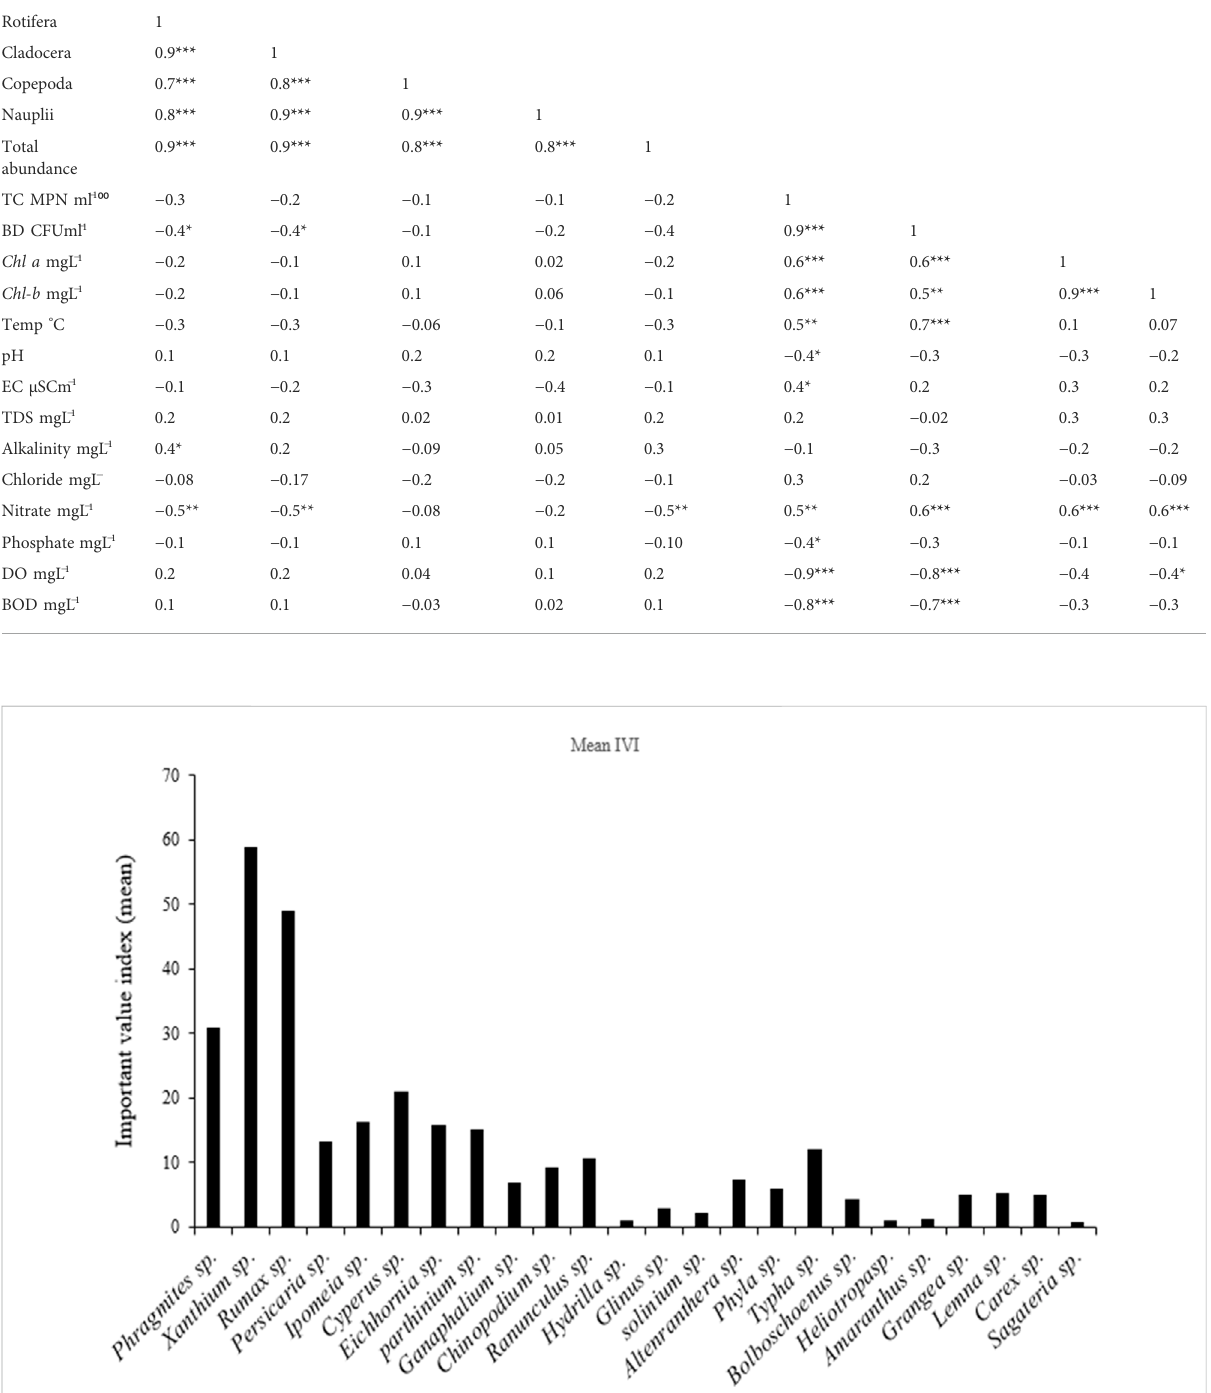
Frontiers in Environmental